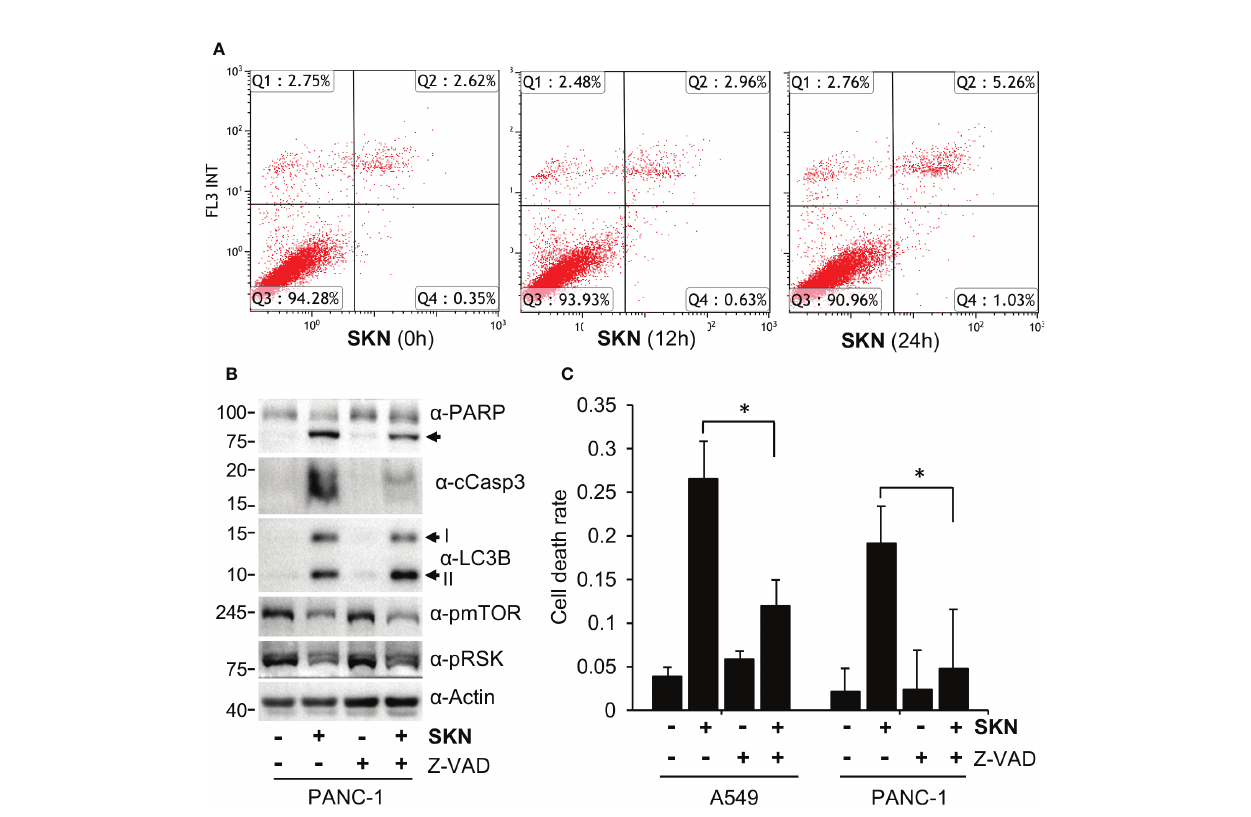
FIGURE 5 | Apoptosis-dependent cell death induction by Shikonin. (A) A549 cells were treated with 5 m M of Shikonin for 0, 12 and 24 h, and apoptotic cells were analyzed by Annexin V staining. (B) PANC-1 cells were treated with 5 m M of Shikonin in the presence or absence of 10 m M Z-VAD for 24 h, and protein expression was measured by speci fi c antibodies. Cleaved PARP, LC3B forms I and II are indicated by arrows. (C) Quantitation of dead cell population from B by trypan blue staining. Data represent mean and standard deviation from fi ve replicates. *P <